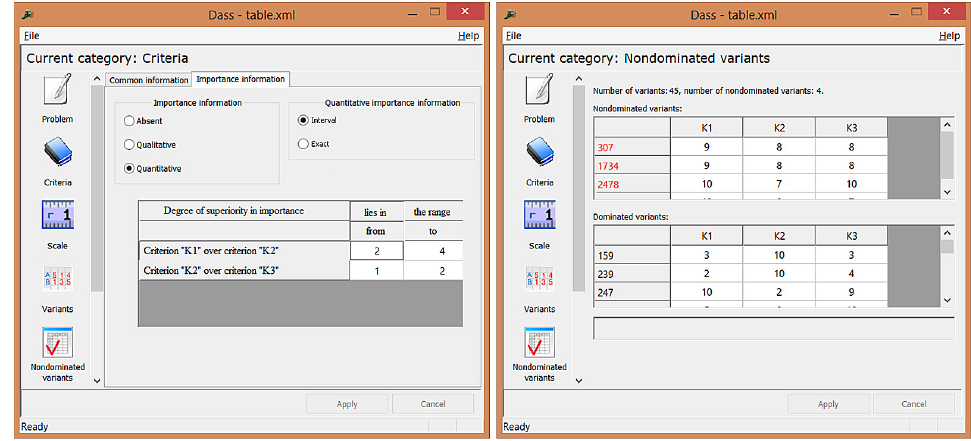
Figure 7. Non-dominated vector scores based on interval information about the importance of criteria.